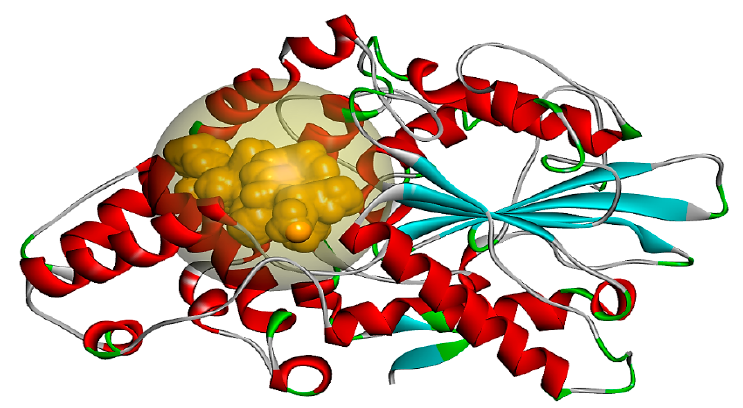
Figure 3. Modeled structure of the Fophy protein based on the aligned sequence between Fophy and Aspergillus Niger Phytase (3K4P_chain A) sequences.